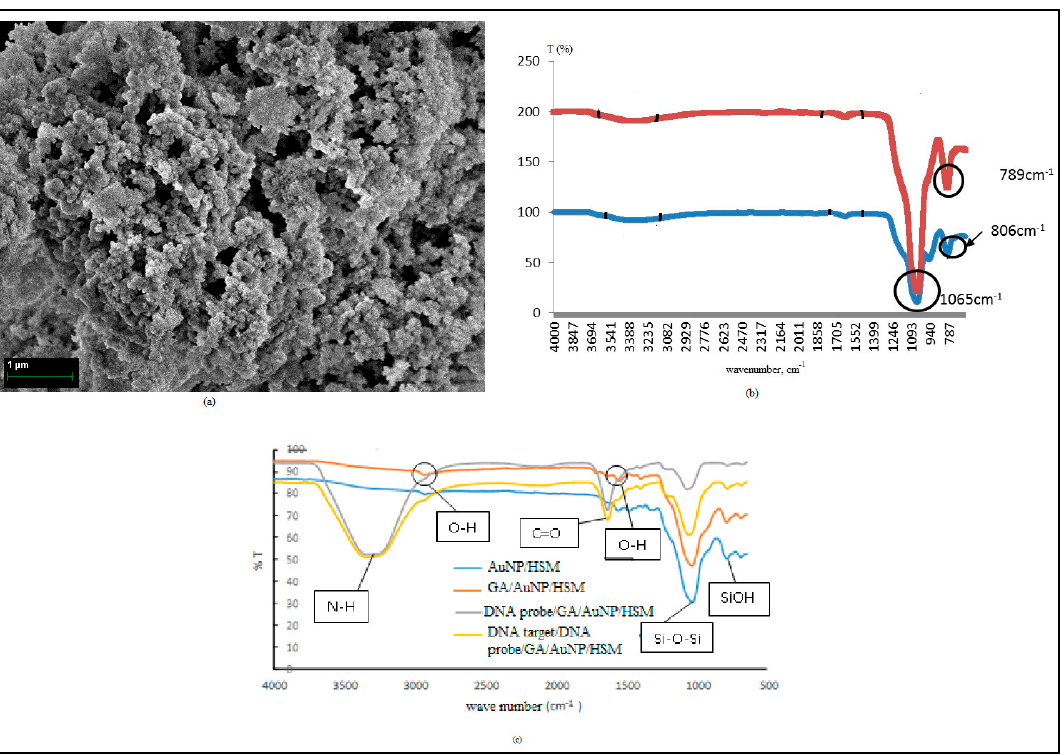
Figure 2. ( a ) FESEM micrograph of HSMs. ( b ) FTIR spectra of HSMs and ( c ) FTIR spectra of the DNA